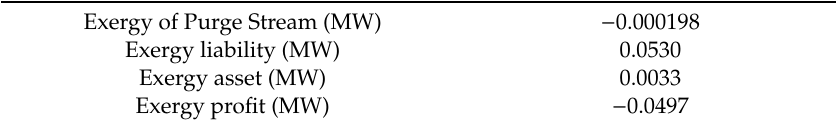
Table 3. Calculation results of the waste acetic acid stream, on the basis of a value of 100 kg / h of the purge stream.